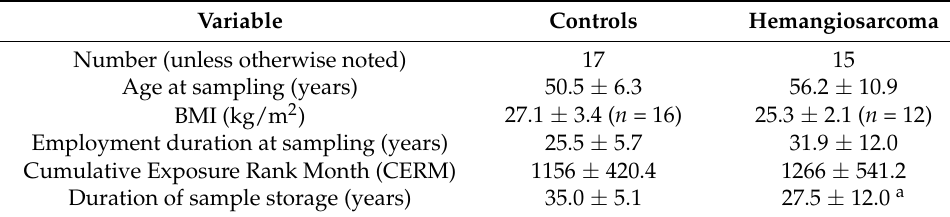
Table 1. Subject Demographic, Employment and Vinyl Chloride Exposure Information.